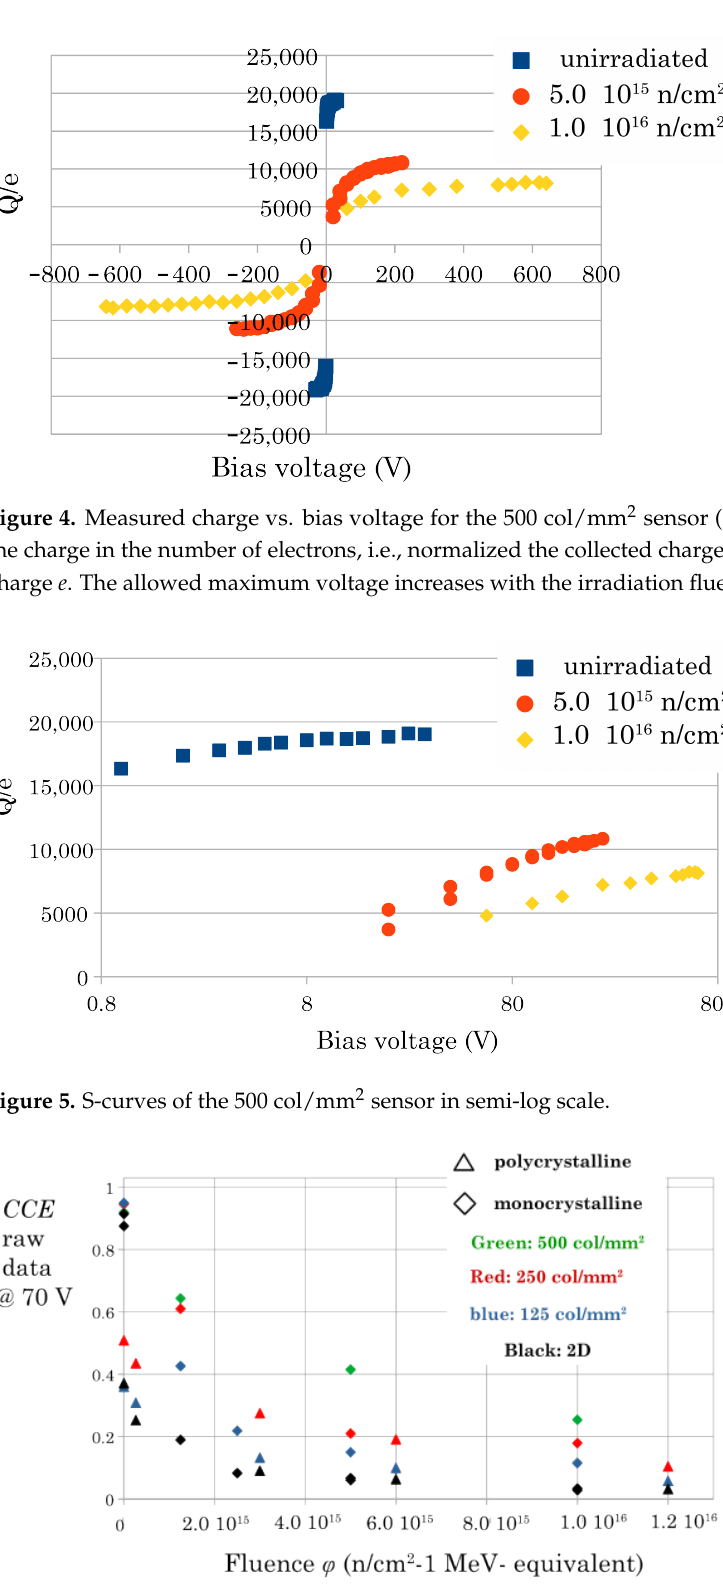
Figure 6. Measured charge collection efficiencies for all the samples at a 70 V bias voltage (see text). The markers are diamonds for the scCVD sensors and triangles for the pCVD material. Different colors denote different geometries as noted in the